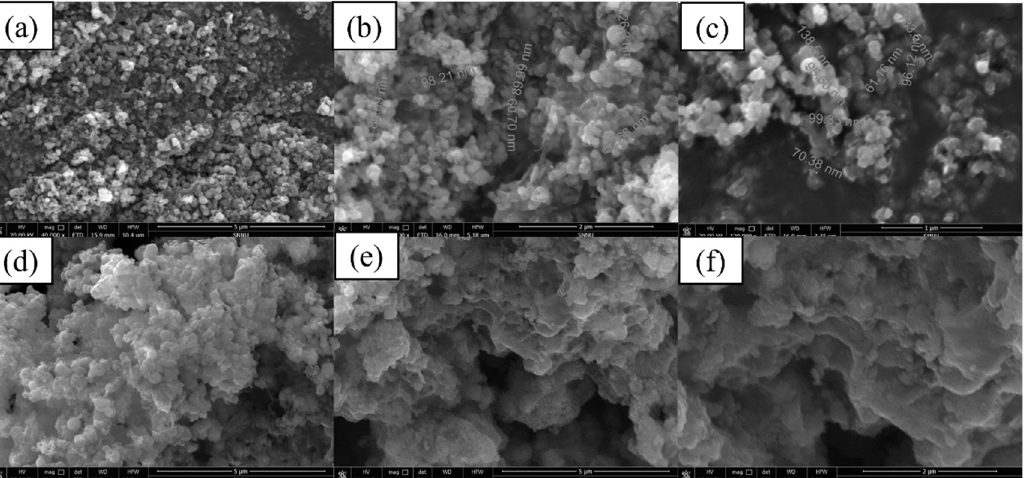
Figure 1. The SEM results of ( a – c ) pre- and ( d – f ) post-reaction of Cr(VI) with nZVI. ([Cr(VI)] = 25 mg/L, [nZVI] = 0.5 g/L, pH = 3, T = 293 K).